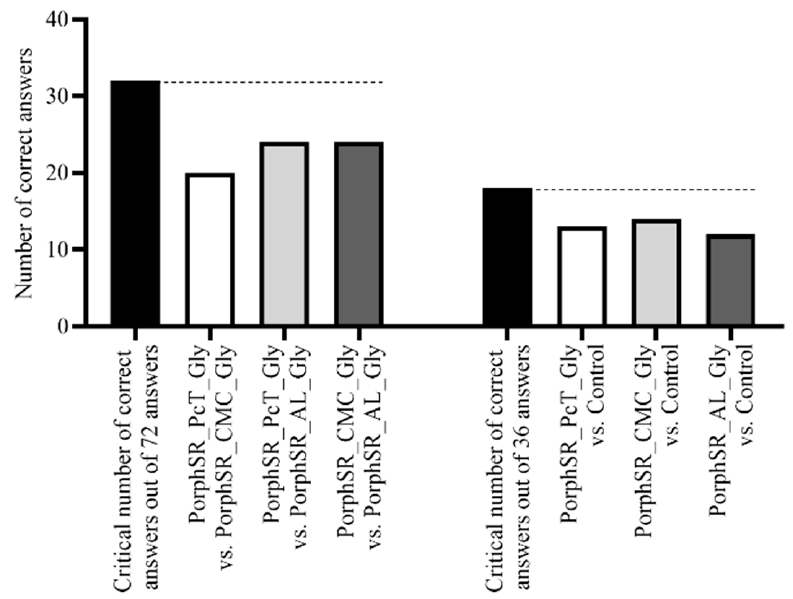
Figure 4. Number of correct answers in the differentiation through sensory analysis of cereal balls with chocolate packaged in PorphSR_PcT_Gly, PorphSR_CMC_Gly, PorphSR_CMC_Gly) and in polyethylene (control) films.